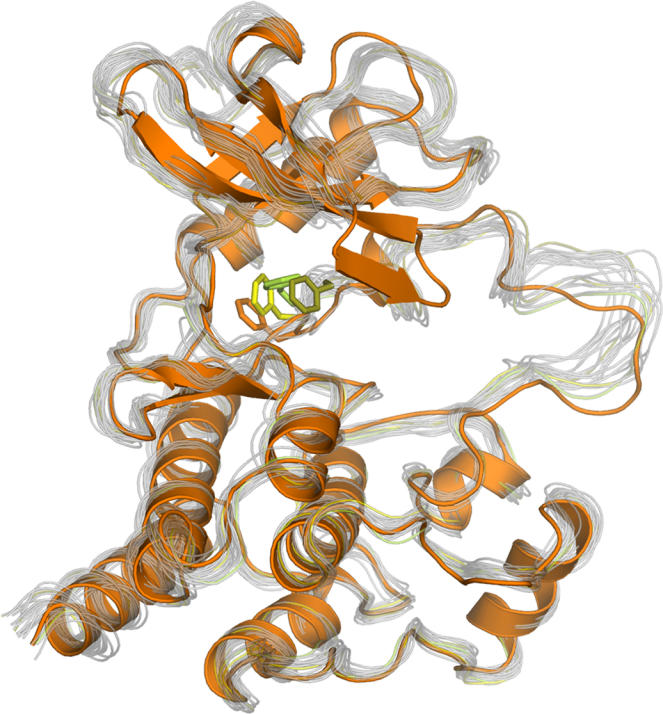
Simulations of the SCR-like inactive conformation of Abl